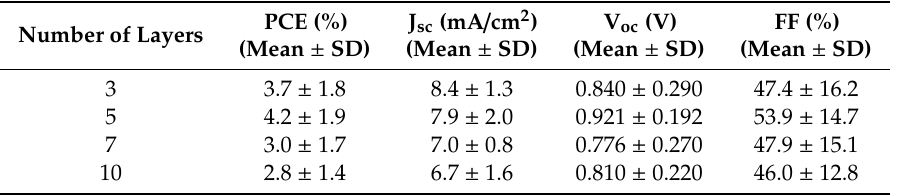
Table 1. Mean and standard deviation (SD) for the photovoltaic figures of merit of devices with di ff erent number of QDs layers.